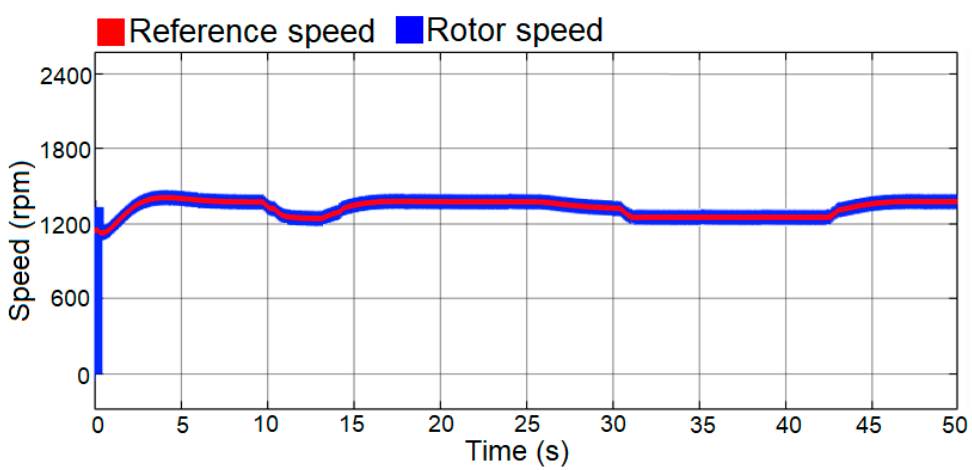
Figure 19. Reference speed and measured speed of the rotor (results from simulation).